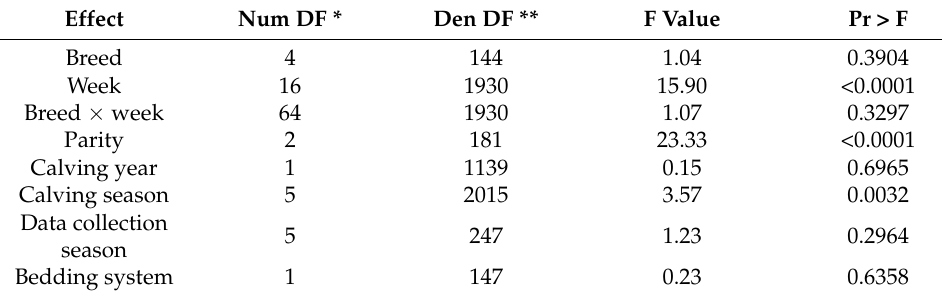
Table A5. Variance analysis results for the variable